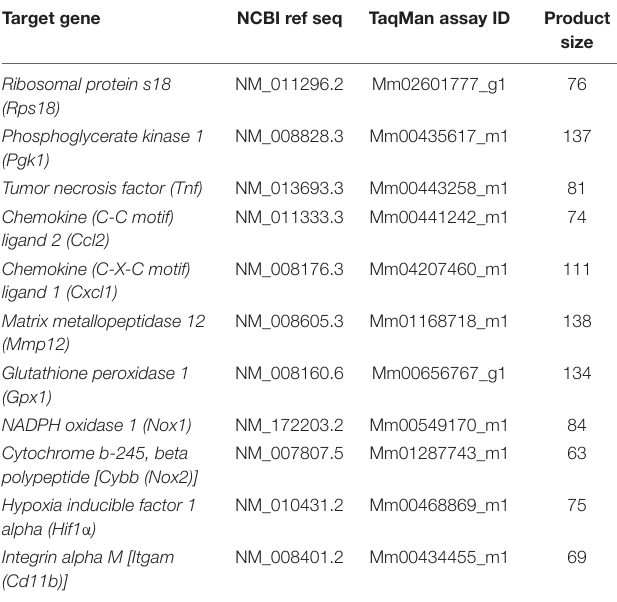
TABLE 1 | TaqMan probes used for